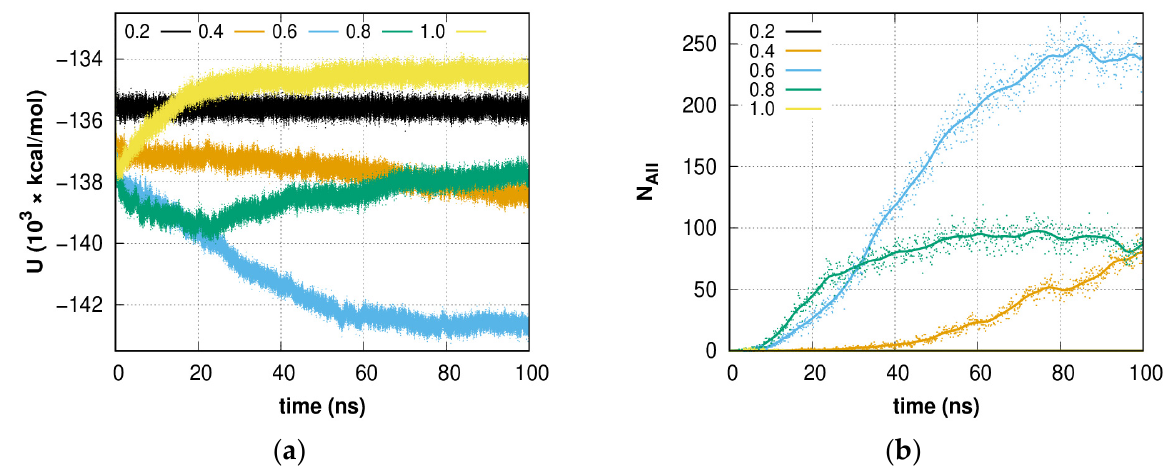
Figure 6. Time dependence of ( a ) system potential energy and ( b ) overall cavity number. Solid lines represent the smoothed data of the cavity number.